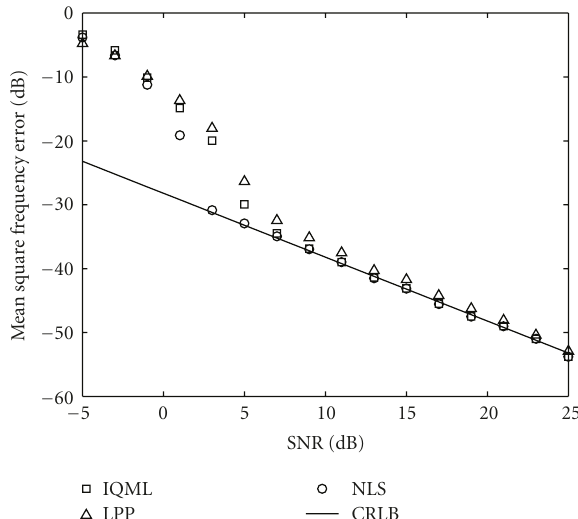
Figure 8: MSE for ω of single real sinusoid with fixed φ